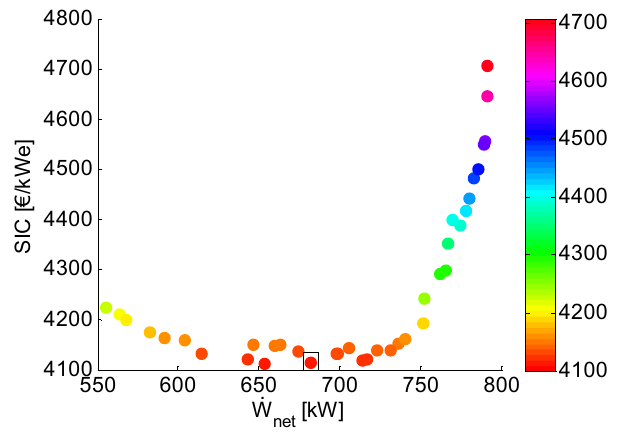
Figure 3. Pareto front SIC vs. net power output ( (cid:1849)(cid:4662) cycle (SCORC).